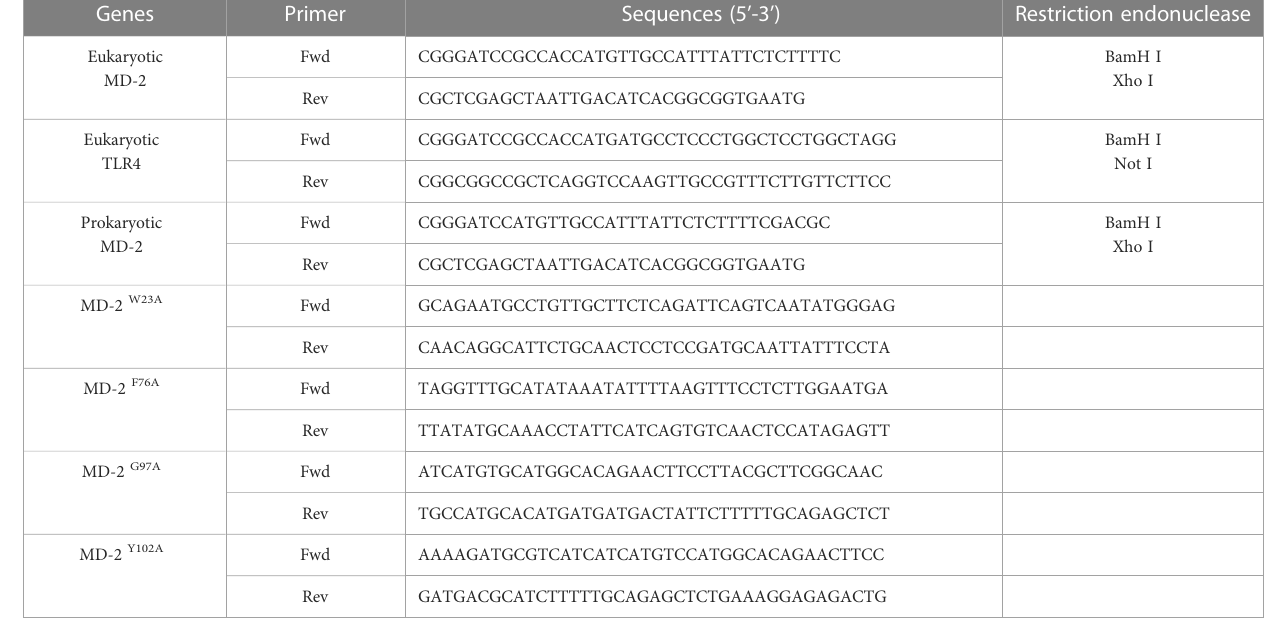
TABLE 1 The primer sequences for plasmid construction.